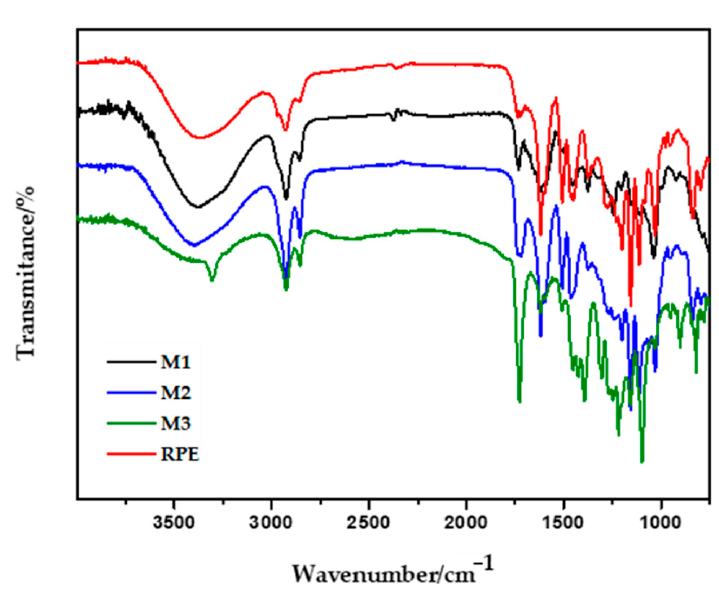
Figure 3 . Attenuated total reflectance-Fourier transform infrared spectroscopy (ATR-FTIR ) related to the polymer membranes loaded with the red propolis extract (RPE) (M1, M2,